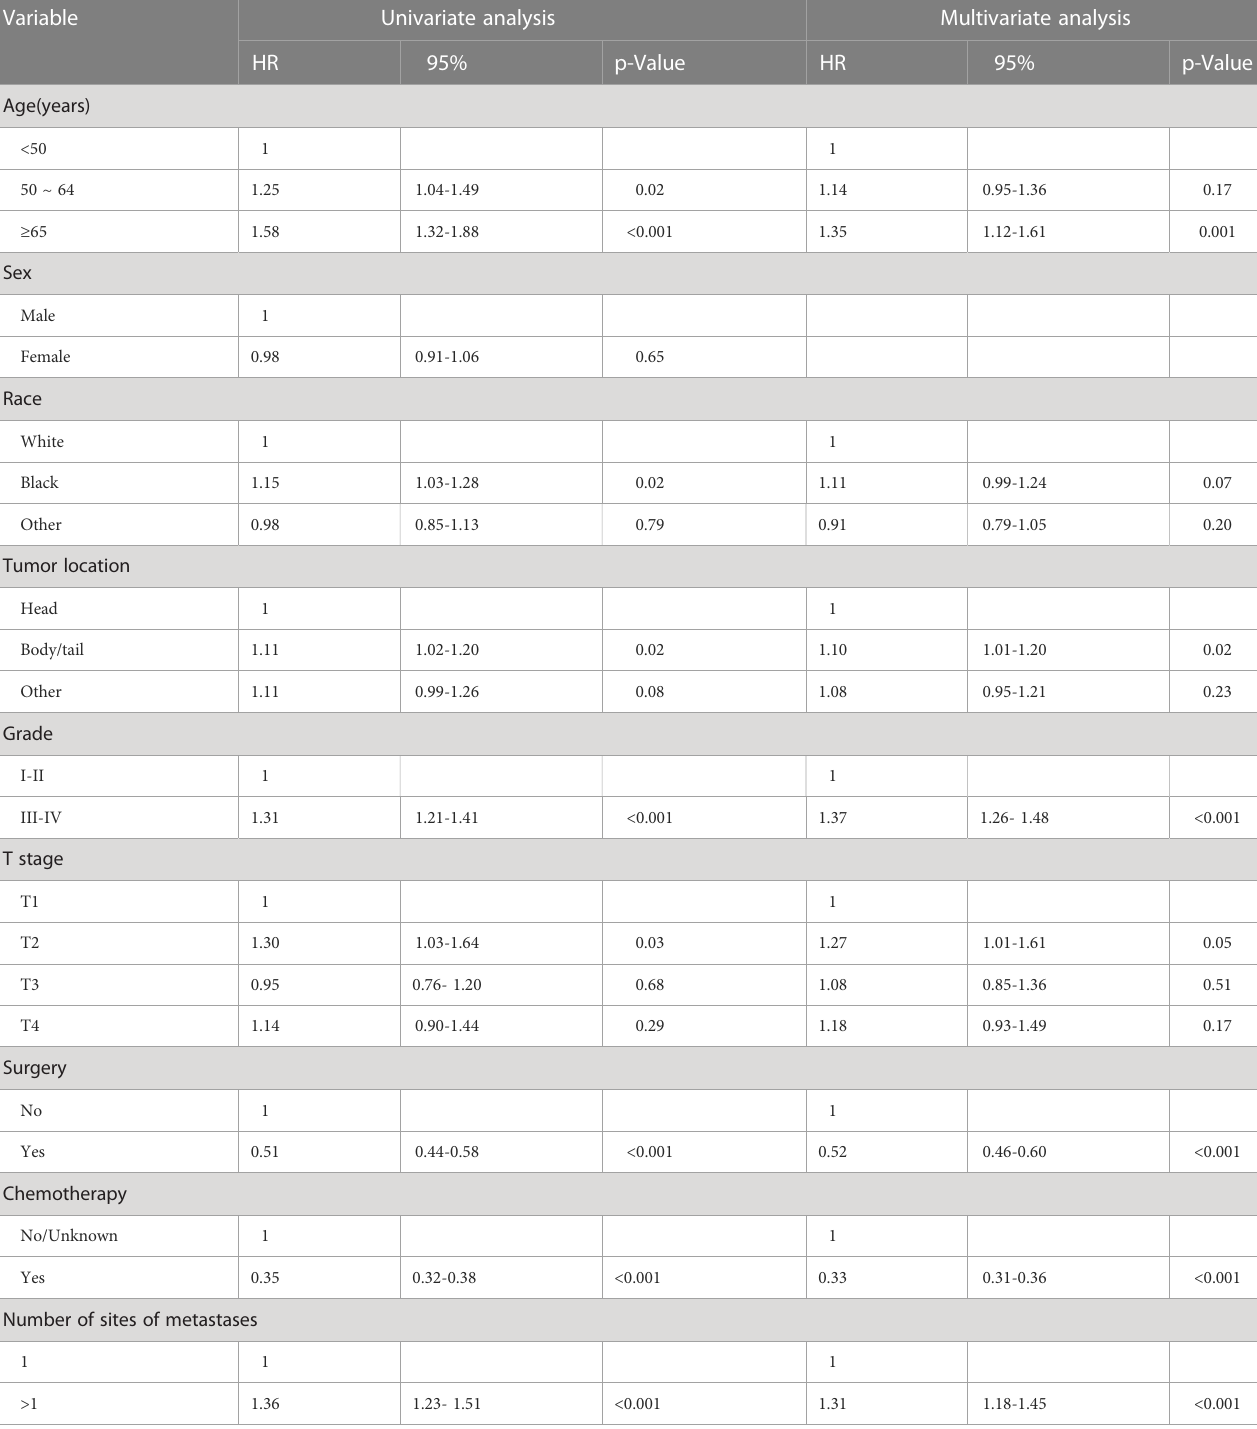
TABLE 5 Univariate and multivariate Cox-analyses of prognostic factors for overall survival in metastatic PDAC patients. Variable Univariate